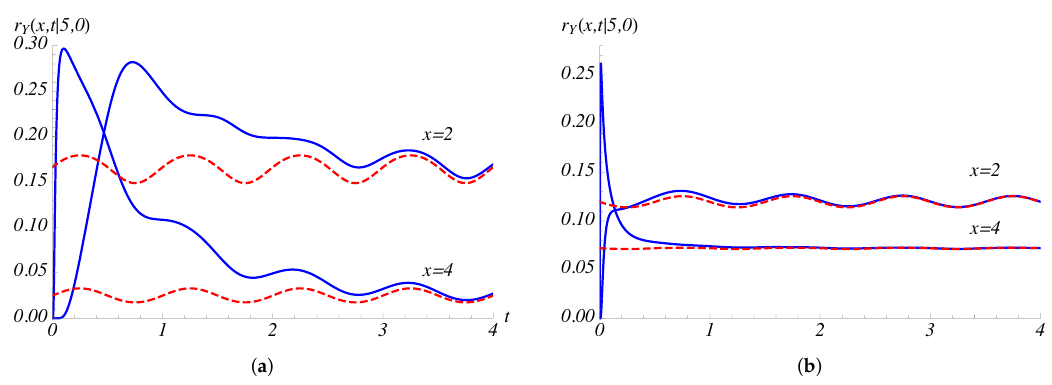
Figure 7. The transition densities, given in (46), are plotted as a function of t for the same choices as Figure 6 with x 0 = 5 for x = 2 and x = 4 (solid blue curves). The dashed curves indicate the corresponding asymptotic densities. ( a ) σ 2 = 0.2; ( b ) σ 2 = 2.